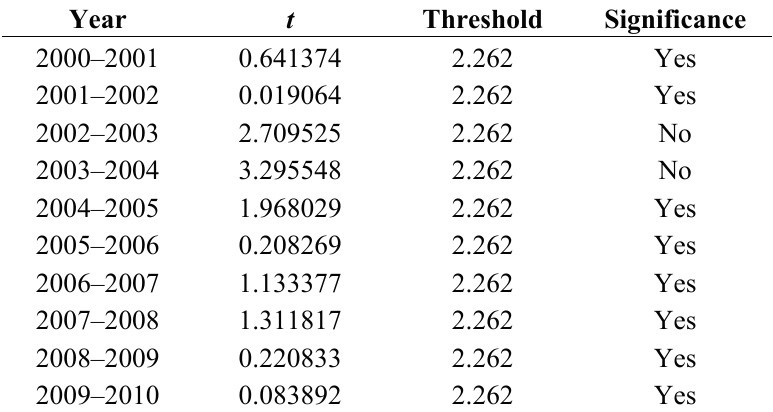
Table 4. Significance analyses between the MODIS-derived results and agriculture statistics on district scale by paired-sample t -test at the level of 0.05.